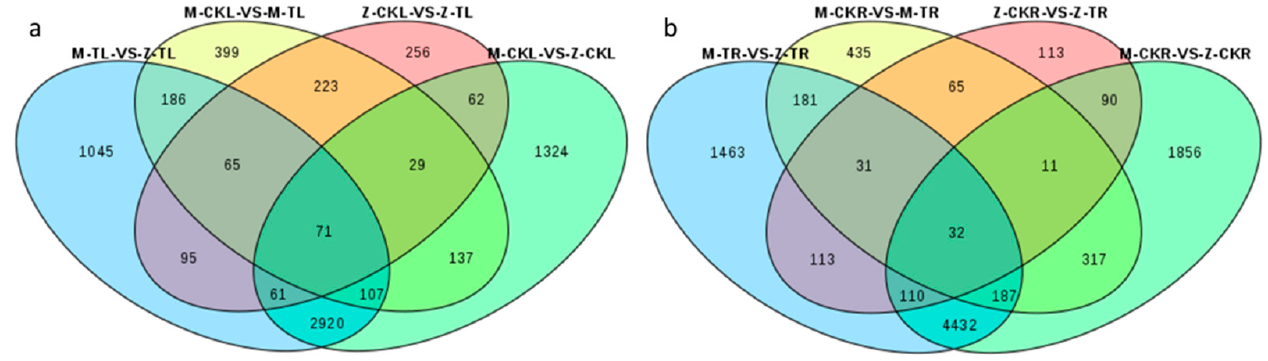
Figure 4. Venn diagrams of DEGs in leaves and roots among different combinations. ( a ) The Venn diagram of DEGs in leaves among different combinations. ( b ) The Venn diagram of DEGs in roots among different combinations.